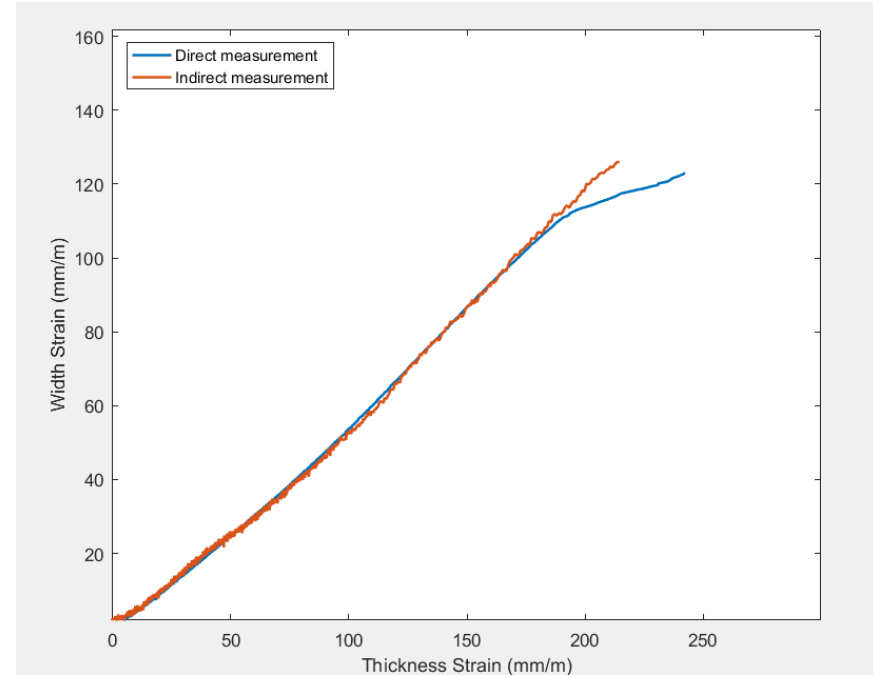
Figure 17. R-value curves of aluminum alloy 6061 in the necking area.